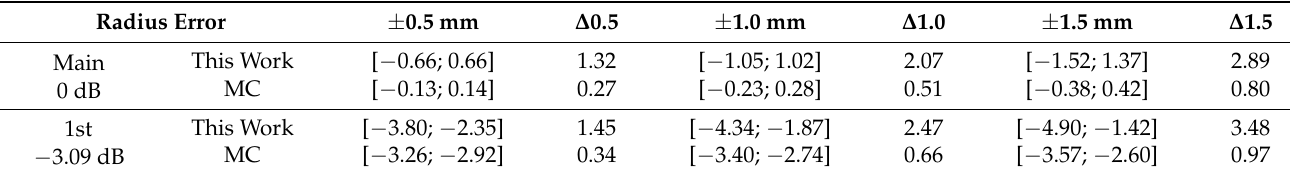
Table 4. Numerical results of SLL of power pattern in Figures 17 and 18.